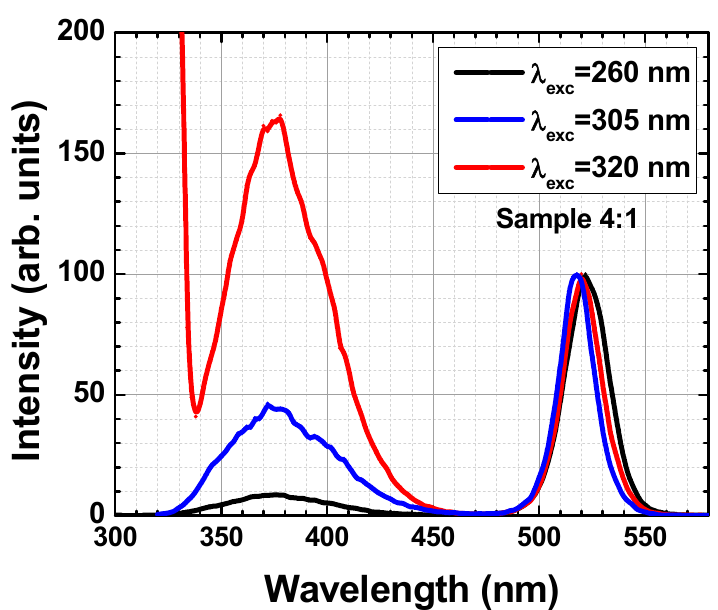
Figure 11. PL spectrum for 4:1 sample excited at different wavelengths in the UV spectral range. The intensity is normalized at the VIS-PL peak.